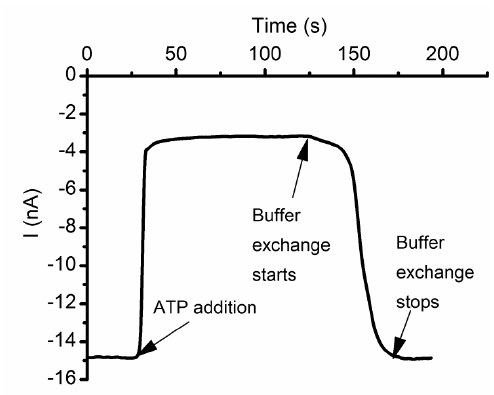
Figure 13. ATP reversibly modulates the macroscopic ionic currents through lysenin channels. The open current through lysenin channels undergoes a major decrease after ATP addition (10 mM final concentration). Buffer exchange with ATP-free support electrolyte reinstates the original conductance, indicative of reversibility. Adapted from [59], with permission.